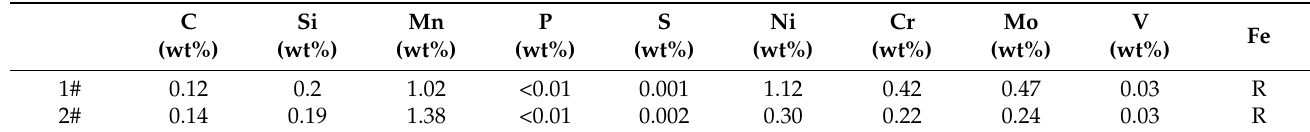
Table 1. Chemical composition of model steels.